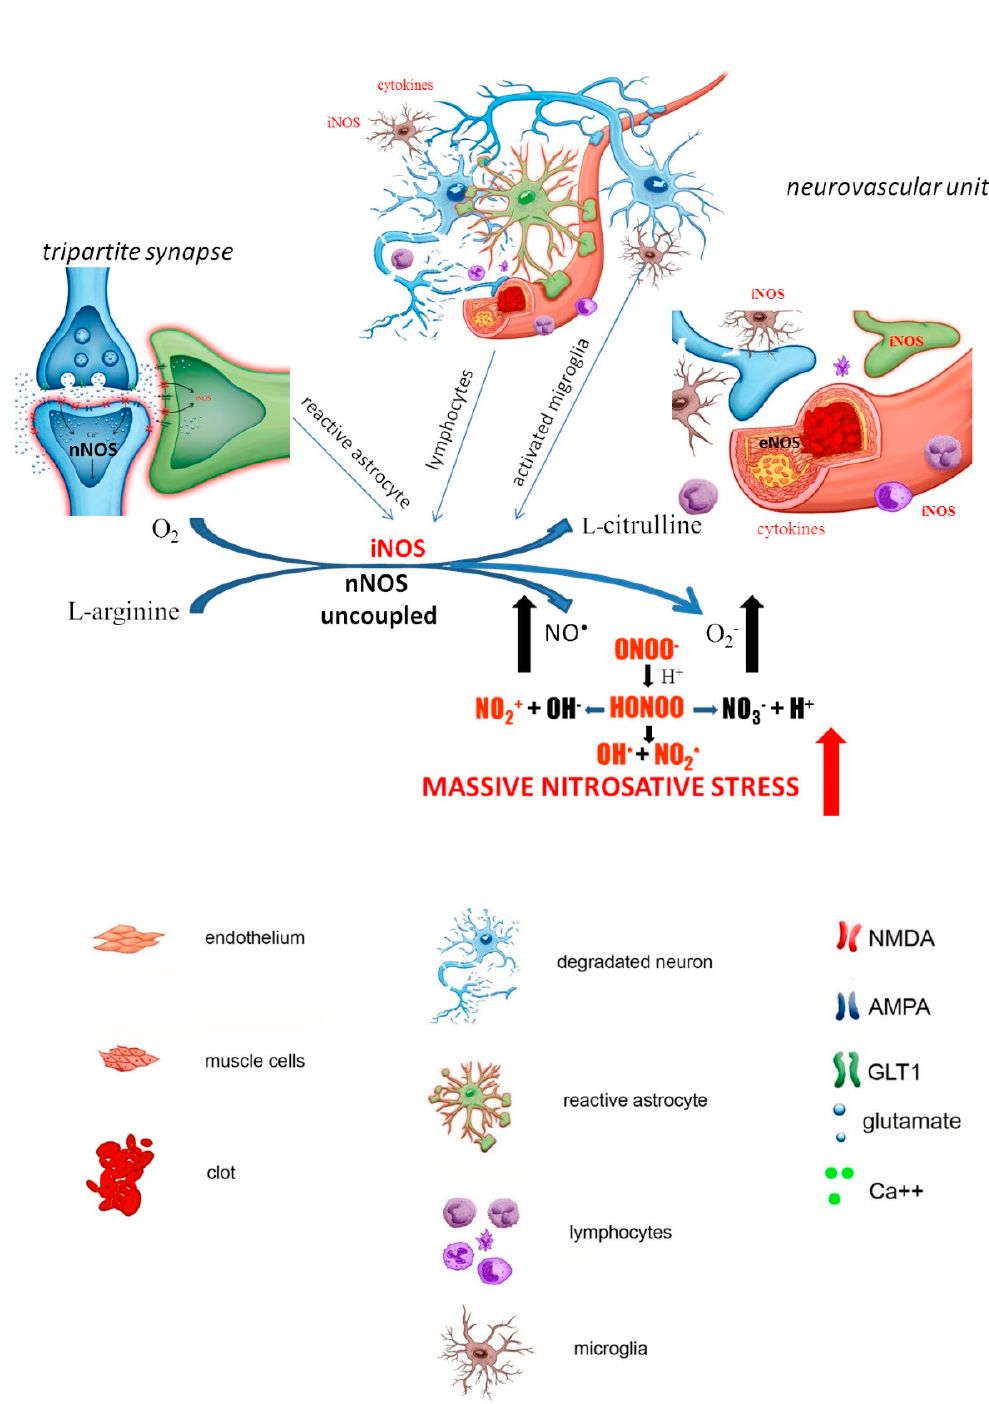
Figure 3. Late stage of the ischemia (delayed neuronal damage (begins several hours after episode and reaches maximal level after 24–48 h): parts of dead neurons attract leucocytes and microglia, which accumulate in the place of the stroke releasing cytokines that start to induce the production of iNOS in these cells. Additionally, astrocytes undergo morphological, molecular and functional remodeling in response to injury and also becoming a source of proinflammatory cytokines and iNOS. Thus, the cascade of events triggered by ischemia leads to massive production of cytokines and accumulation of proinflammatory cells with high activity of iNOS. Under these circumstances, in the strong deprivation of tetrahydrobiopterin (BH 4 ) and/or substrate L-arginine, all uncoupled NOS isoforms generate simultaneously high